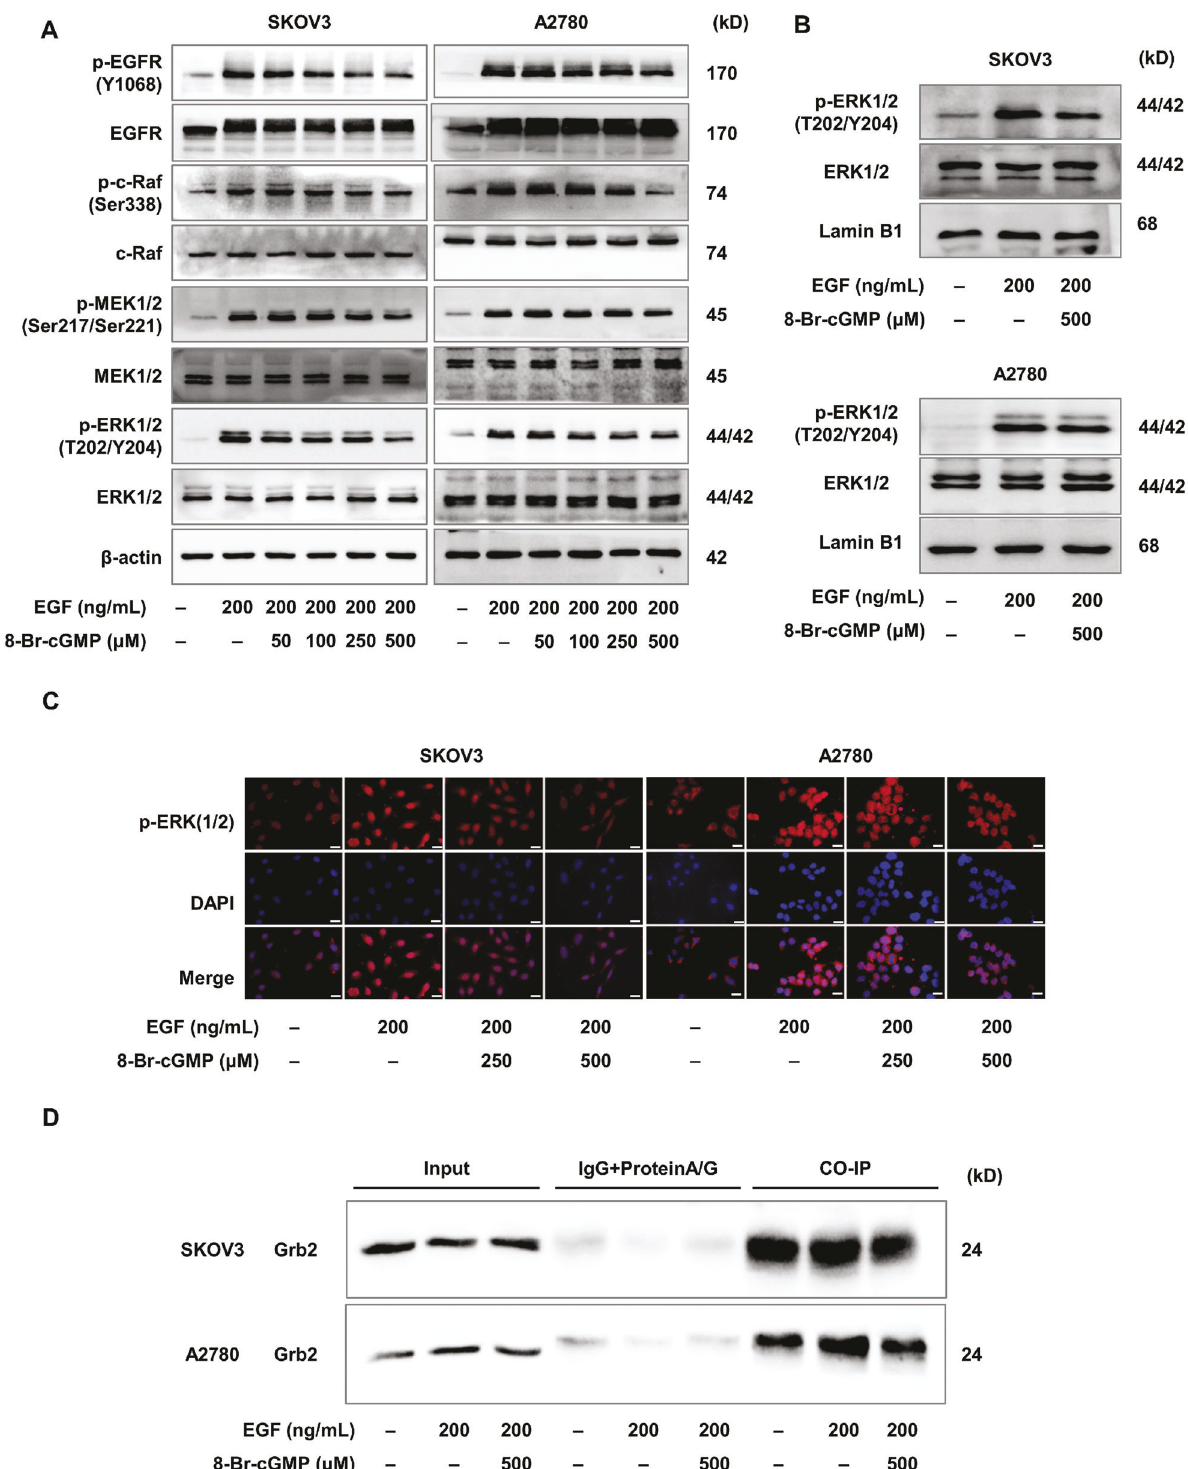
Fig. 6 Activation of PKG I inhibited EGF-induced EGFR/MAPK/ERK pathway. A The activation of PKG I inhibited the phosphorylation levels of EGFR, c-Raf, MEK1/2, and ERK1/2 in SKOV3 and A2780 cells. Western blot ( B ) and immuno fl uorescence imaging ( C ) analysis the expression of nuclear phosphorylated ERK1/2 in SKOV3 and A2780 cells. Represent images were shown, respectively. Scale bar, 50 μ m. D The Co-IP assay revealed that the 8-Br-cGMP-induced EGFR/MAPK/ERK pathway blockade via hampering the EGF-induced EGFR-Grb2-SOS1 binding. activity was inhibited. This data suggested that elevated PKG I phosphorylation and decreased tyrosine phosphorylation. This led activity attenuated EGF-induced EOC cell proliferation and to the decrease of phosphorylated downstream proteins of EGFR, migration via the MAPK/ERK pathway, serving as a potential including c-Raf, MEK1/2, and ERK1/2. Consequently, the nucleus target for EOC treatment. translocation of phosphorylated ERK1/2 and related transcription Cell Death and Disease (2023)